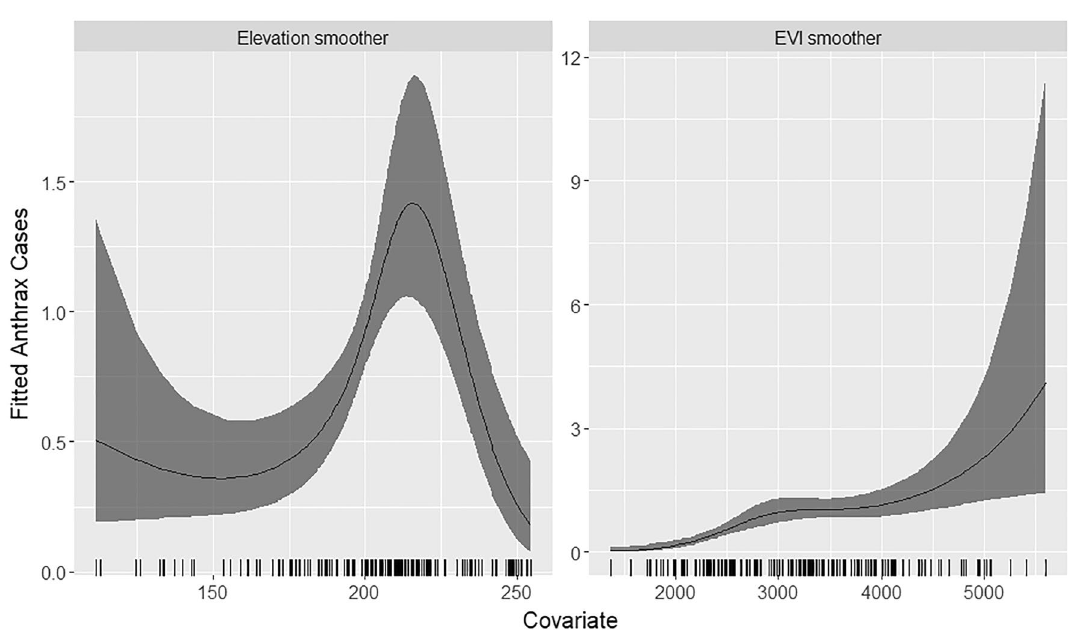
Figure 5. Smoothed fits for Enhanced Vegetation Index (EVI) (units) and elevation (m). The solid black line shows the posterior mean of the smoothing function, and the shaded grey areas represent the 95% credible intervals. The y-axis shows the estimated incidence of anthrax. The figure was generated using R software v. 4.1.0 28